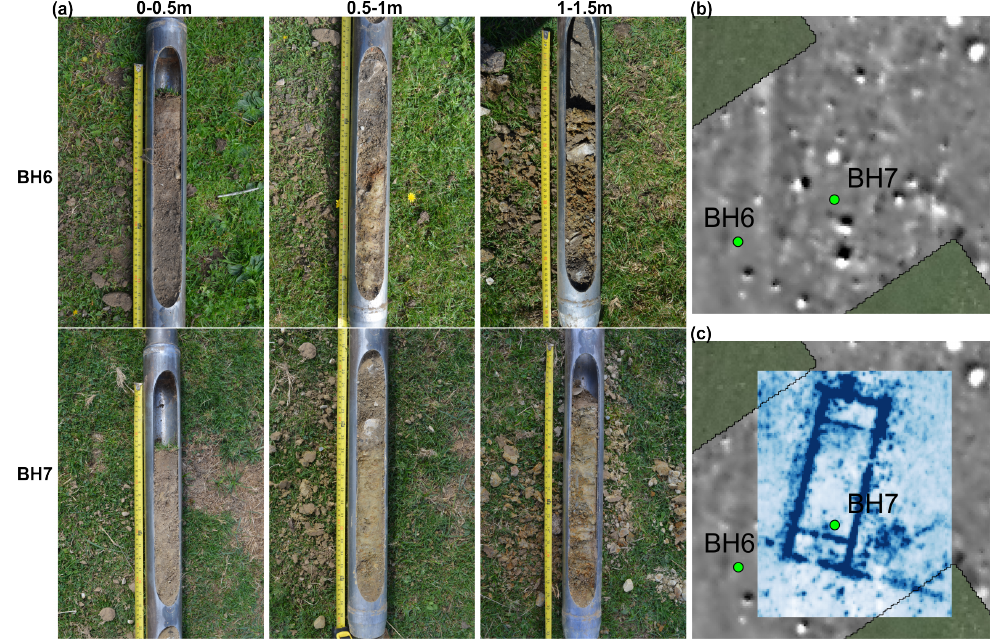
Figure 7. ( a ) Pictures of the sediment cores extracted on locations BH6 and BH7; ( b ) Magnetic results of the area where the location of the cores can be seen; ( c ) GPR results over the same area, where the building is clearly defined (time slice at 0.37–0.54 m bgl, v = 8 cm/ns, high reflection in dark). The area is highlighted in the general context of Figure